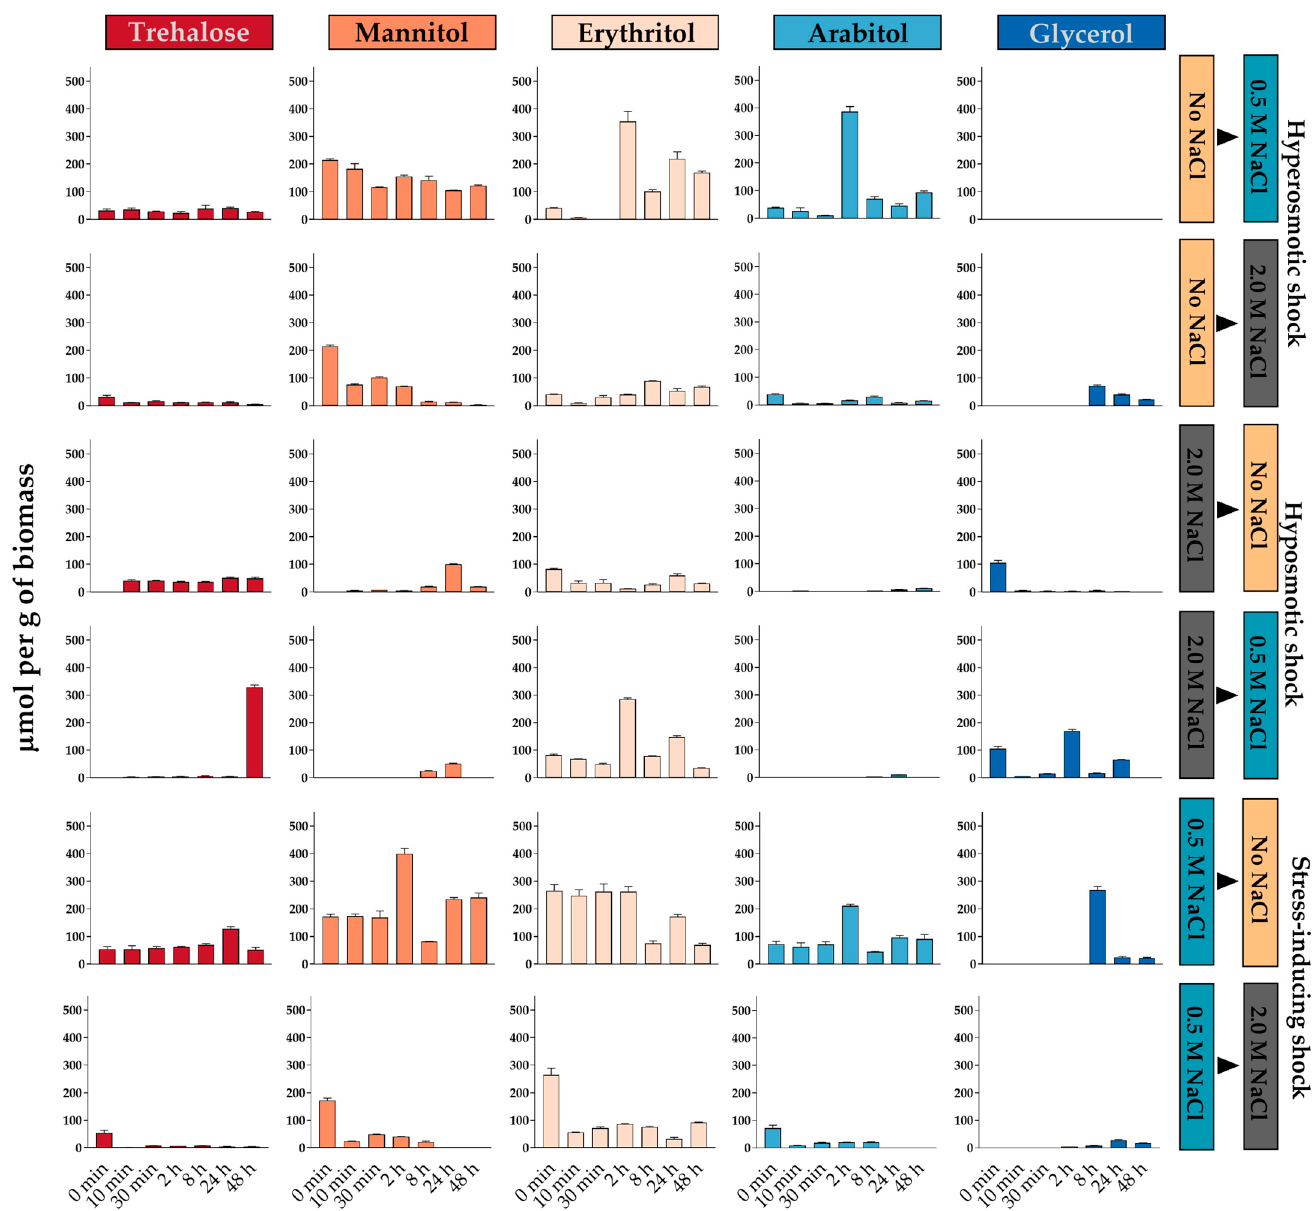
Figure 4. Accumulation of compatible solutes in A. sydowii after different osmotic shocks. The labels on the right indicate the culture conditions before and after the osmotic shock. The data represent the average and standard deviation of at least three replicates ( n = 3). Statistical analyses of the data are summarized in Supplementary Table S5.